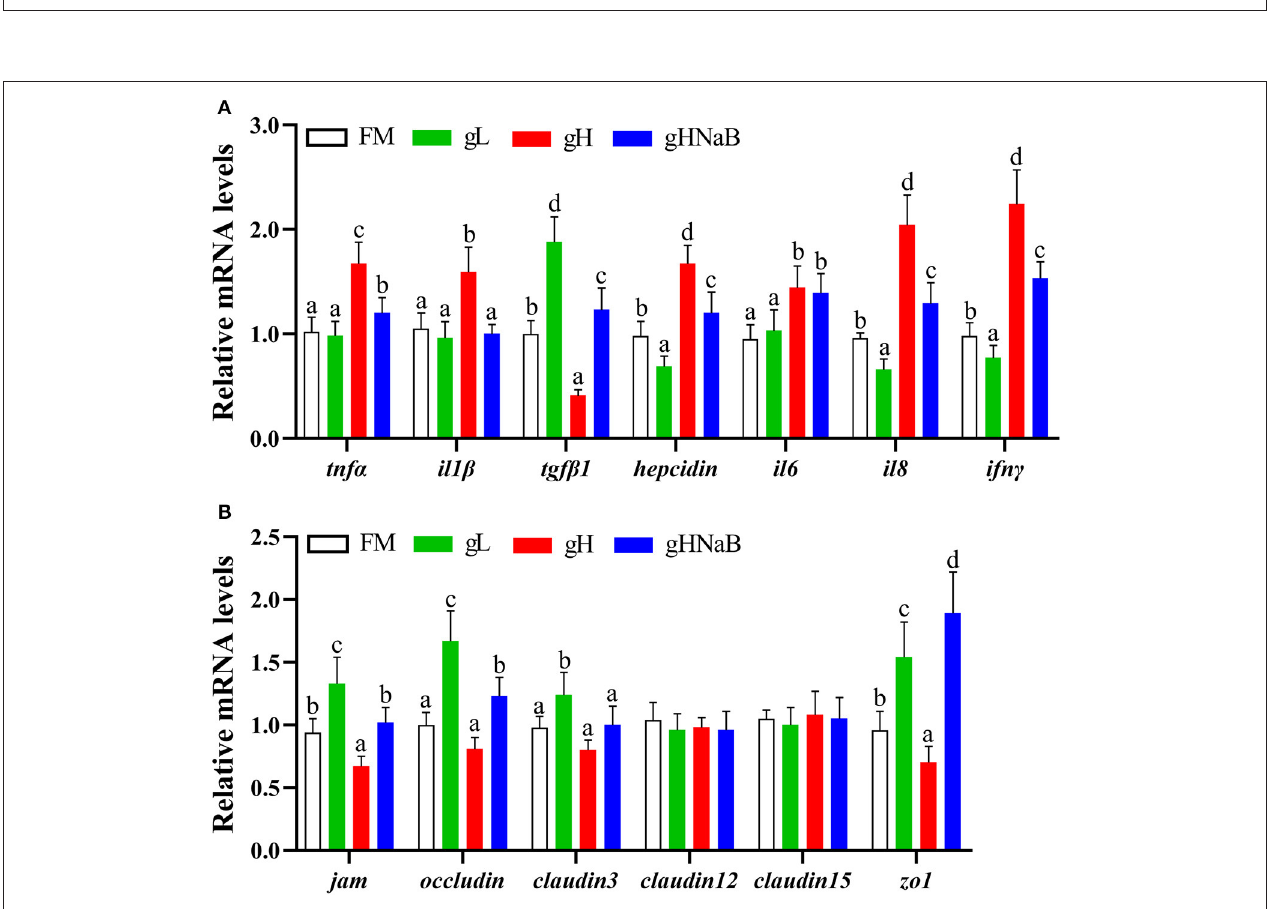
caspase8 , caspase9 , pi3k p85 , 3pdk1 , akt , foxo4, and fasl in